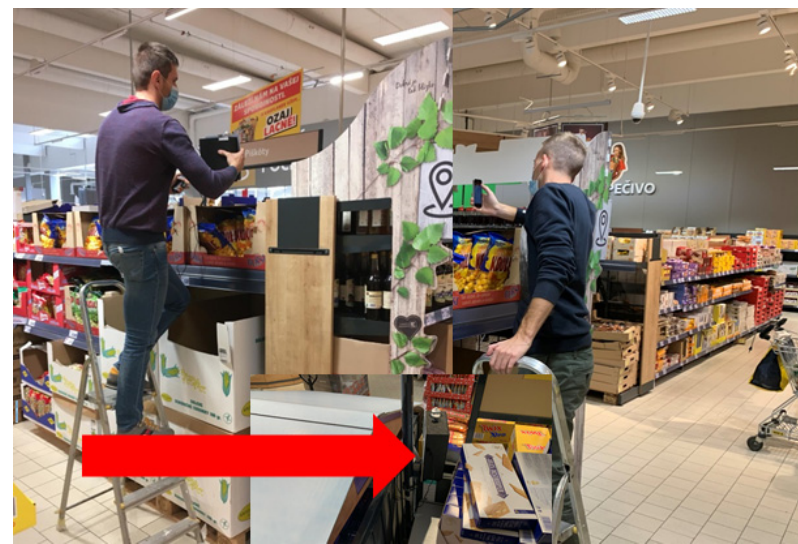
Figure 2. Installation of aromatising units in retail outlet.